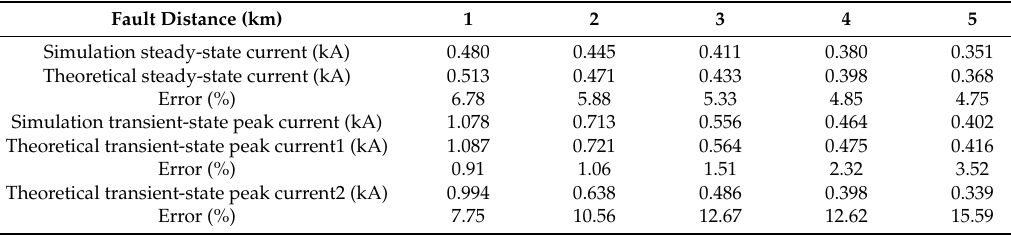
Figure 7. The waveform of the surge current of simulated values; theoretical values in [4] and this paper. Table 2. Simulation parameters and computed initial values.